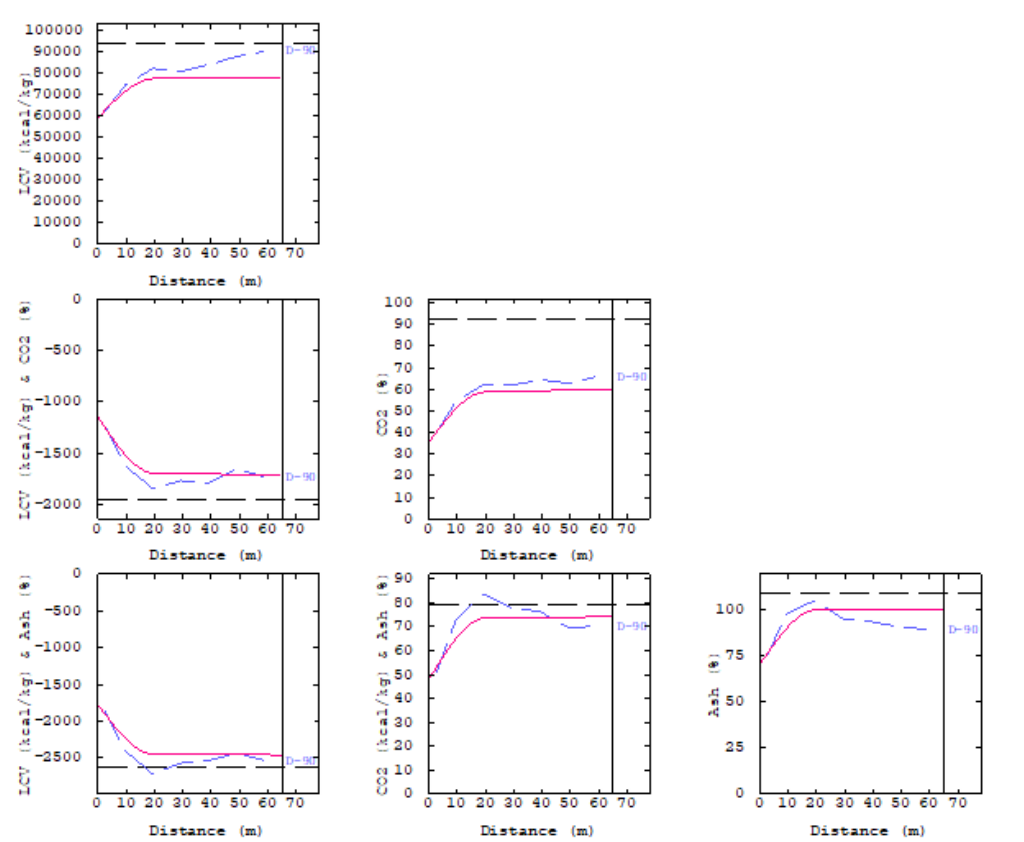
Figure 10. Experimental and model cross variograms for LCV, ash, and CO 2 in the vertical direction. Experimental structure is modeled by an isotropic spherical variogram. Dashed polygonal lines (blue color) symbolize experimental variograms; thin dashed lines (black color) symbolize variance and covariance; continuous lines (red color) symbolize variogram models.